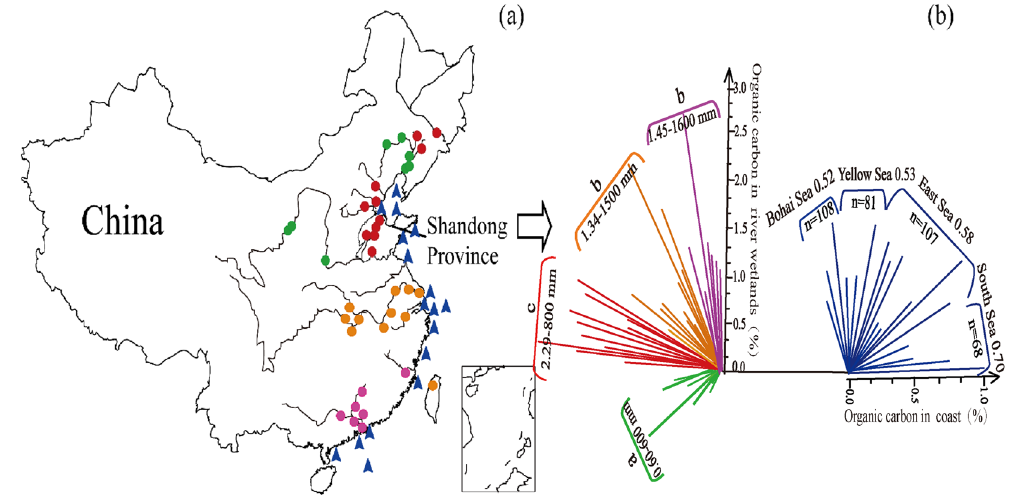
Figure 6. National distribution of sampling stations and organic carbon contents. Map shows the: ( a ) national sampling stations including inland and coastal areas, and ( b ) organic carbon contents of inland and coastal areas with different precipitation. Colors of ( a ) and ( b ) are similar in both a and b maps 4, 18–51 . Areas followed by the same lowercase letters ( a , b and c ) are not significant at α = 0.05 (Duncan test). (Software of